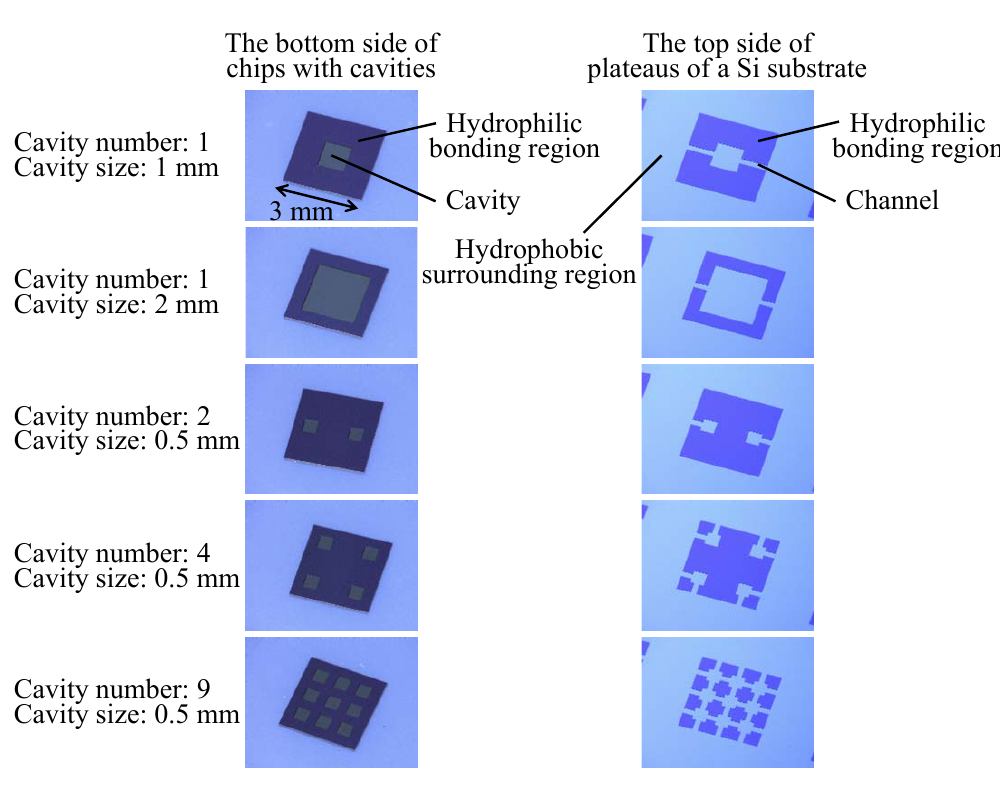
Figure 2. Photomicrographs of fabricated chips with cavities, and substrates with channels.